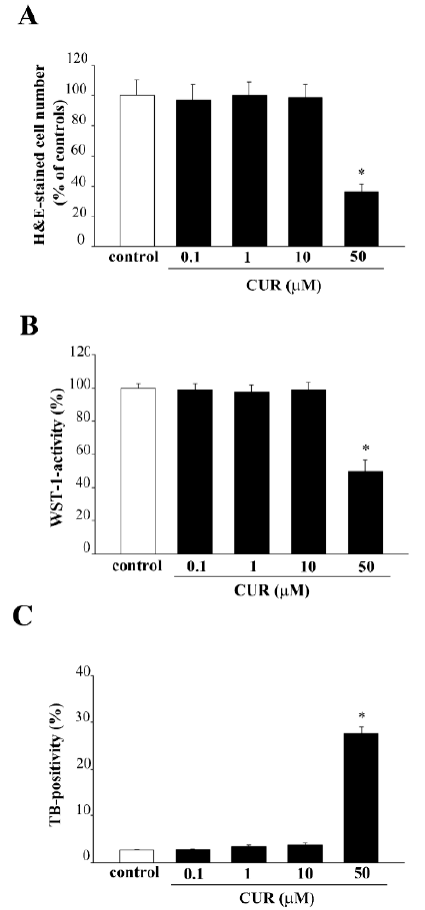
Figure 1. Effects of CUR on PC12 cell survival. PC12 cells were treated for 72 h with increasing doses of CUR (0.1 µ M, 1 µ M, 10 µ M and 50 µ M). Then, cell viability was measured both in control and CUR-treated cells following ( A ) H&E staining, ( B ) WST-1 assay and ( C ) TB staining. * p ≤ 0.05 compared with control.